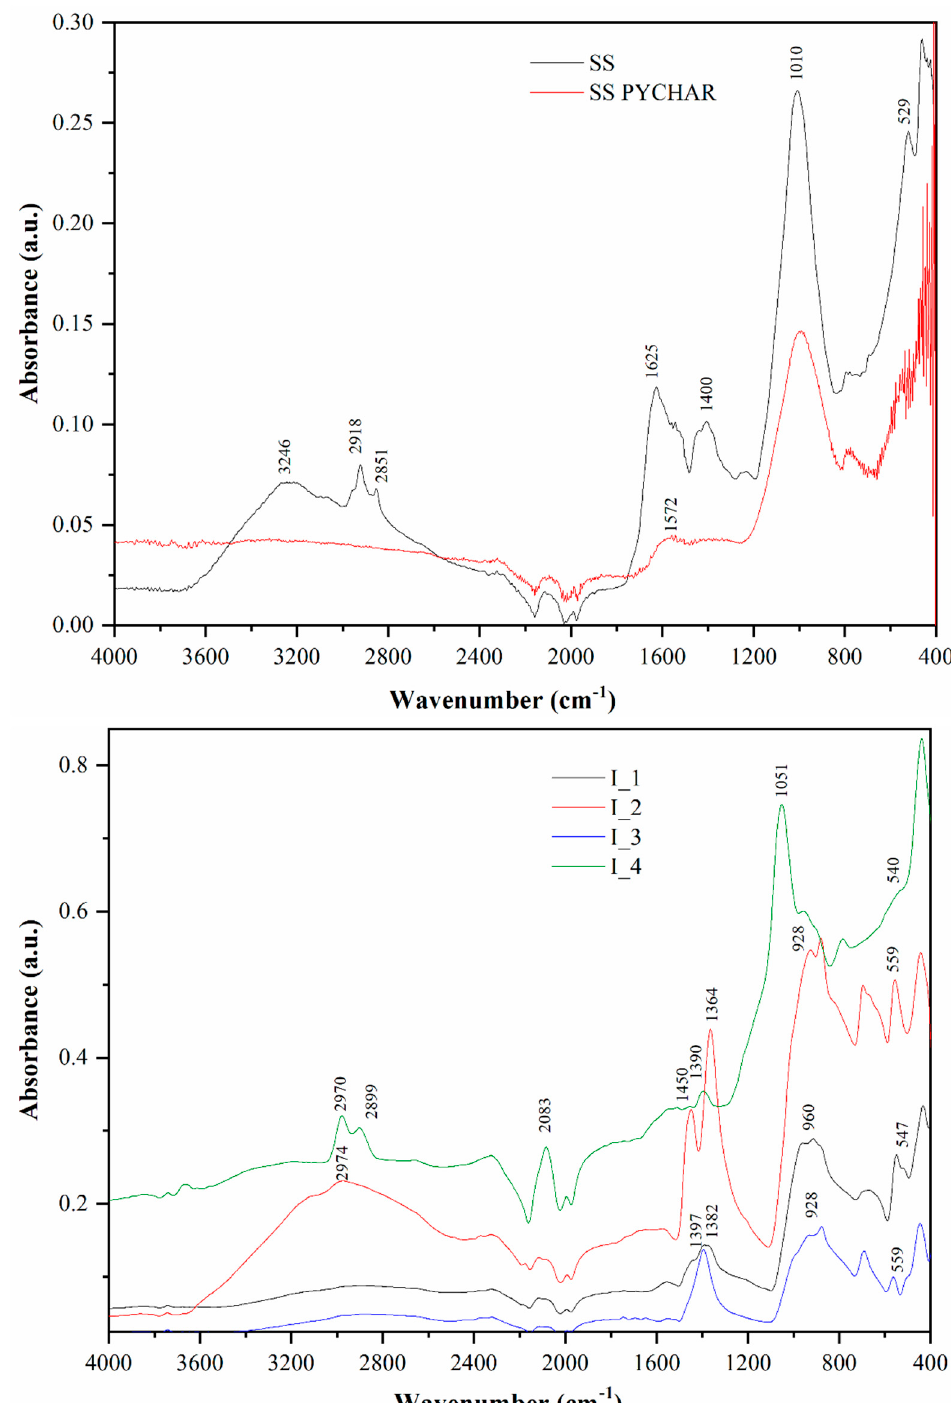
Figure 7. FTIR spectra of the sewage sludge and its activated chars.